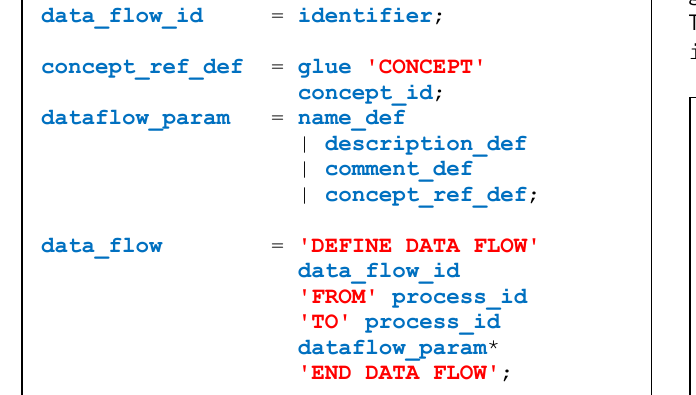
Fig. 5. Data flow definition in the proposed DSL language.